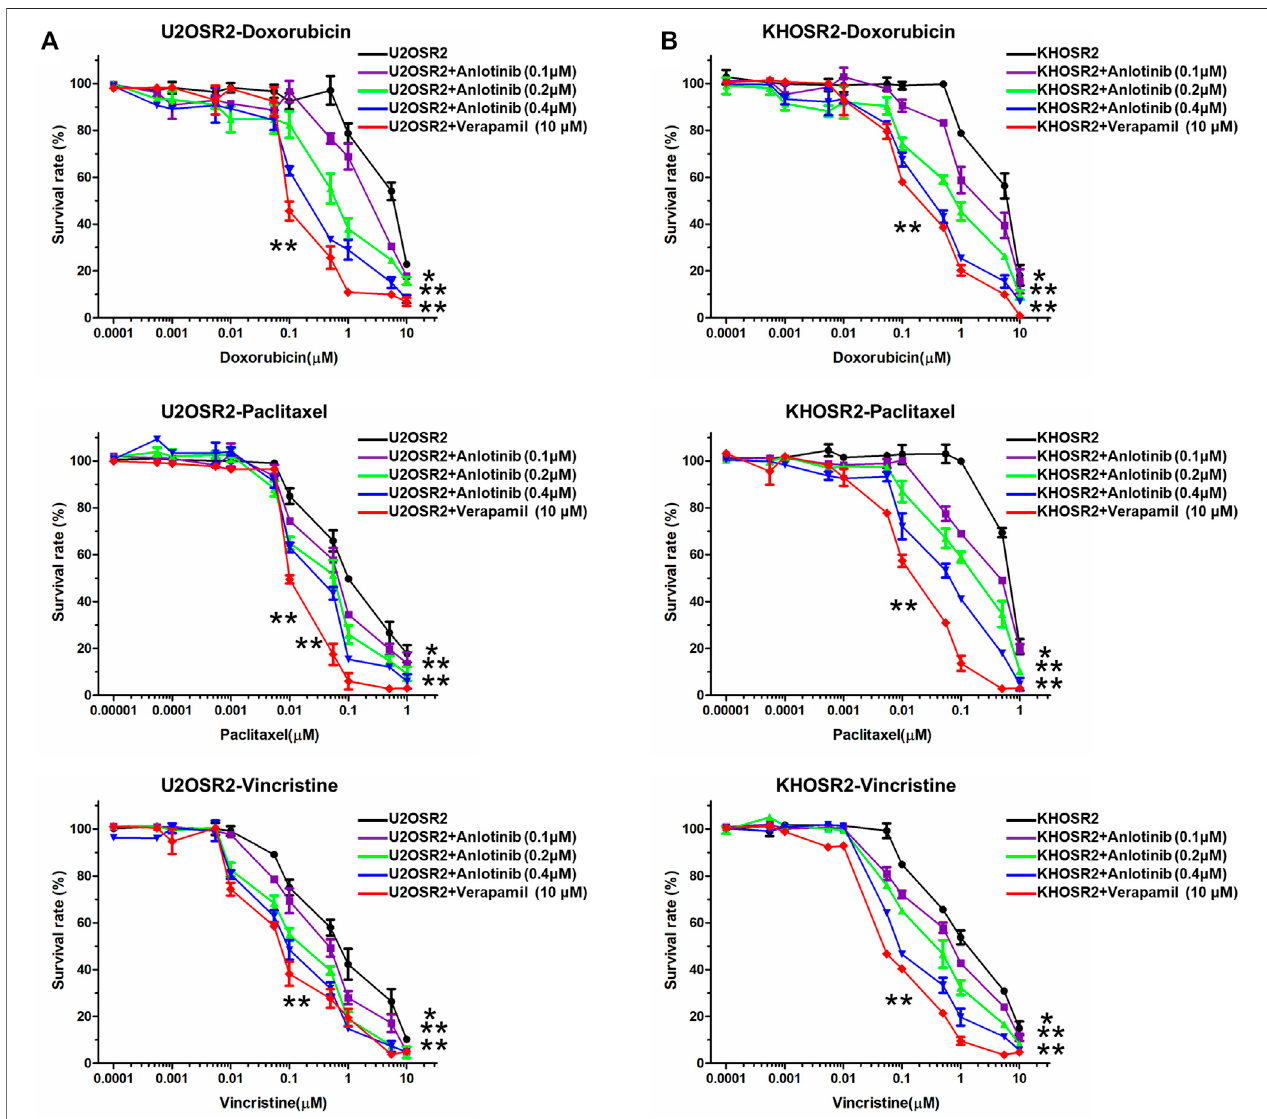
FIGURE2| Effectofanlotinibonthereversalofdrugresistanceinmultidrug-resistantosteosarcomacelllines.Cellsweretreatedwithchemotherapeuticdrugsand anlotinib at the indicated concentrations. The relative sensitivity of each line to chemotherapeutic drugs was determined by a CCK8 assay 48 h after treatment. (A) . Reversal of drug resistance by anlotinib in U2OSR2 cells. (B) . Reversal of drug resistance by anlotinib in KHOSR2 cells. Data represent the mean ± SD of at least three independent experiments (* p < 0.05; ** p < 0.01).